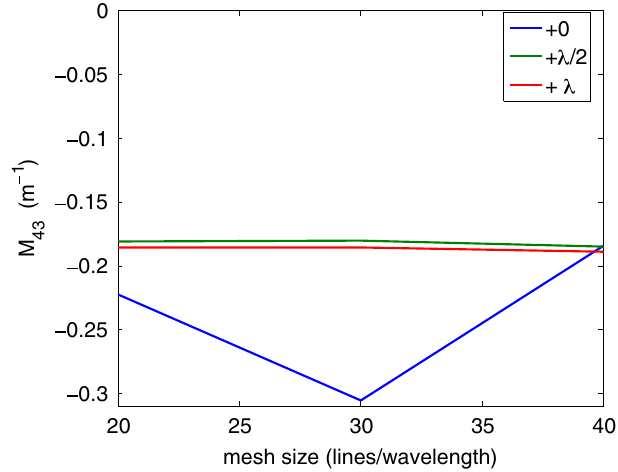
FIG. 8. M focusing element for various coupler lengths and y;p y mesh sizes.